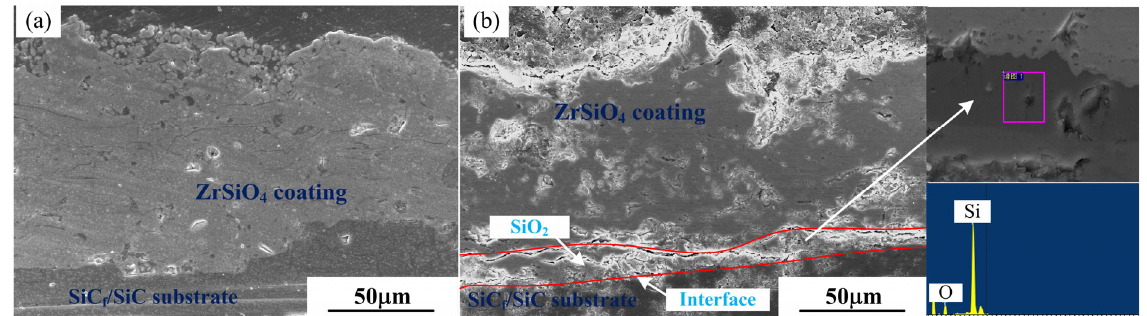
Fig. 6 Morphology of the section of the ZrSiO 4 coating (a) before and (b) after